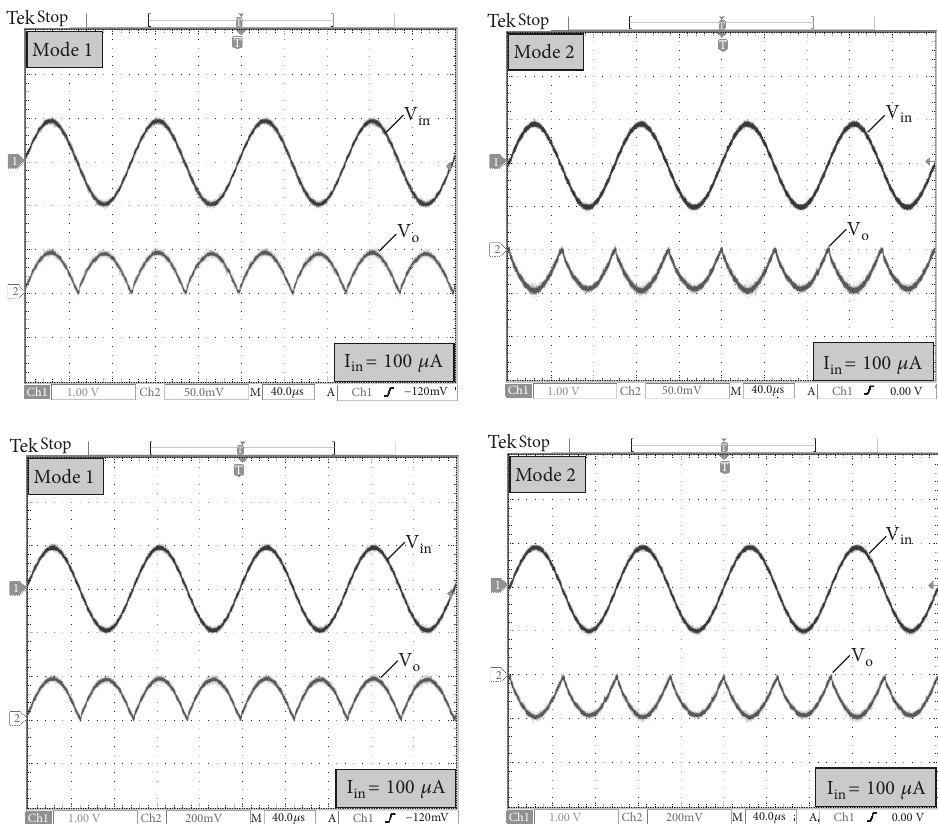
Figure 16: Experimental results of the tunable rectified output amplitude for the circuit (Figure